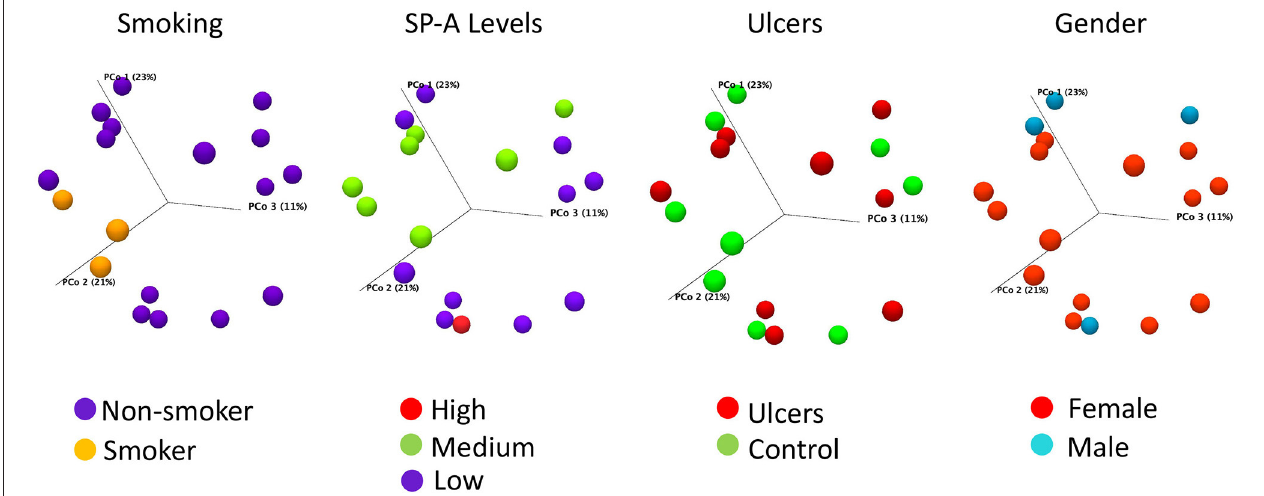
FIGURE 2 | Bray-Curtis PCoA plots of salivary microbiome samples, colored to illustrate the distribution by smoking status, SP-A level, oral ulcer condition, or gender. Axis one accounts for 23% of sample variance, while axis two and three account for 21 and 11% of variance, respectively. Smoking ( p = 0.03) and SP-A levels ( p = 0.03) have significant influences on community composition, as assessed by PERMANOVA analysis, while oral lesions and gender do not. SP-A levels were categorized as Low for concentrations between 0 and 2ng/ml, Average for 2–4ng/ml, and High for